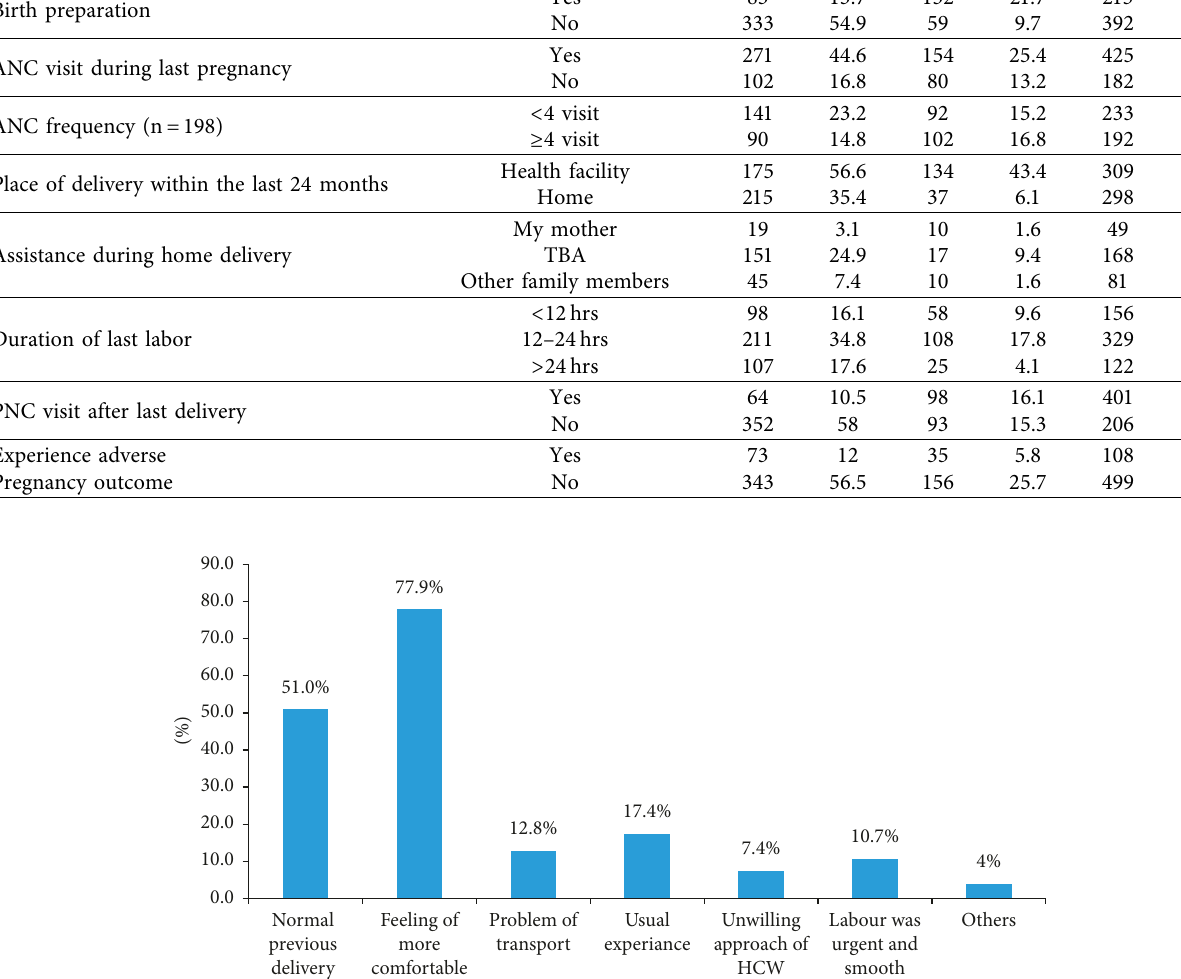
Figure 1: The reasons for home delivery among the respondents in the Kembata Tembaro zone, Southern